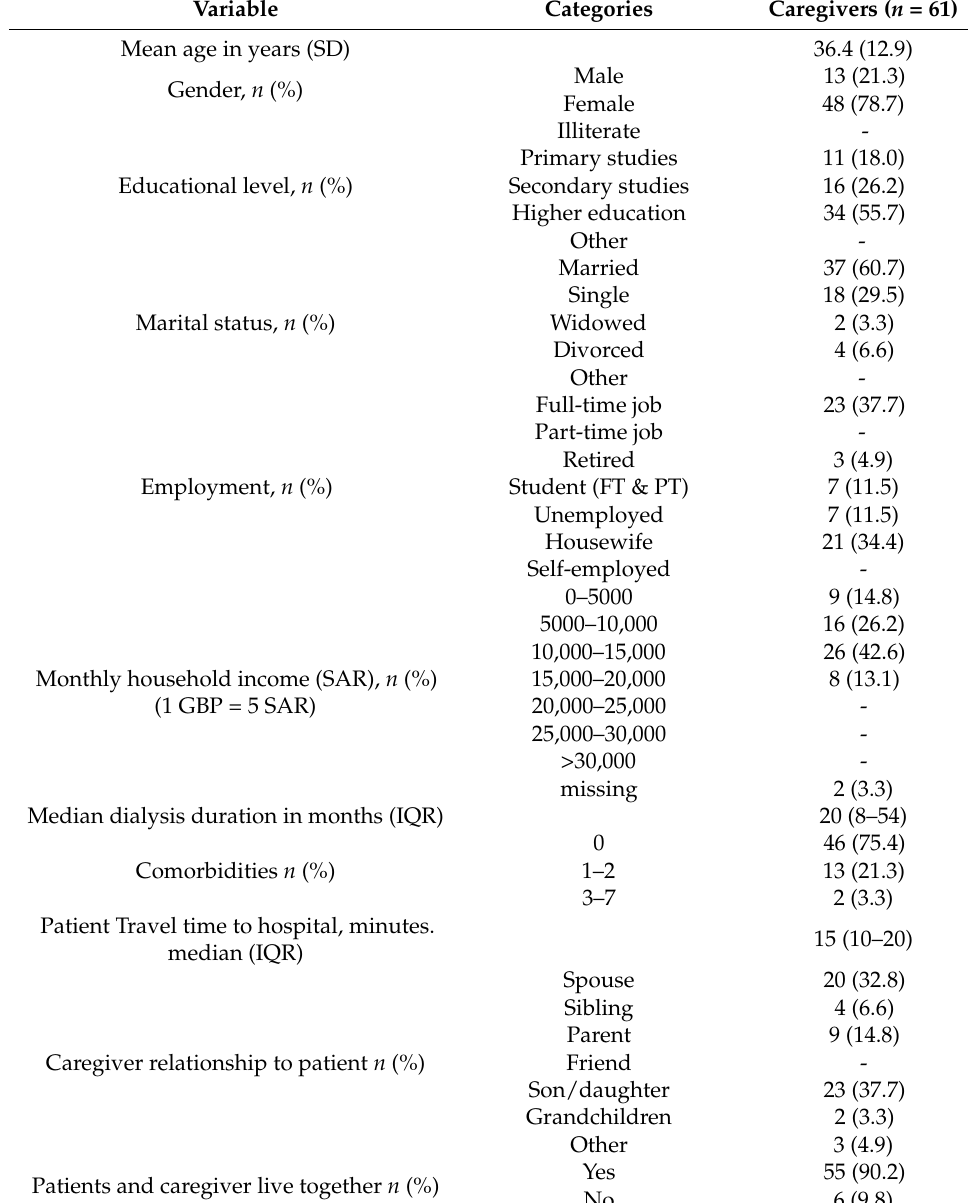
Table 1. Demographic characteristics of caregivers for phase